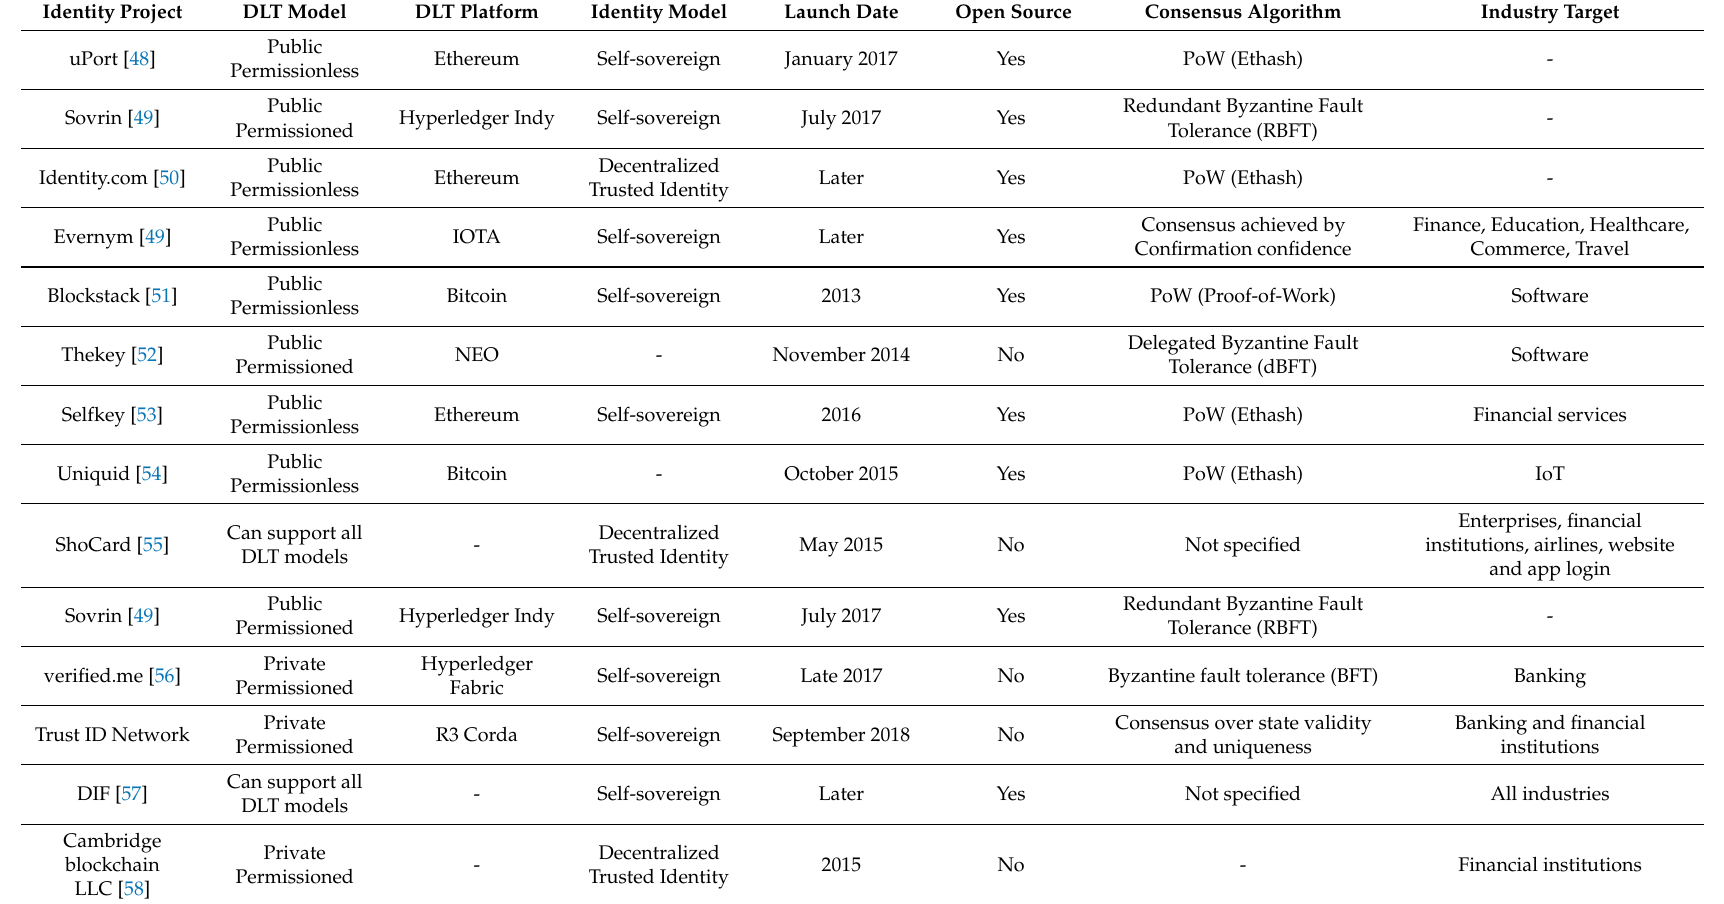
Table 5. Decentralized identity management